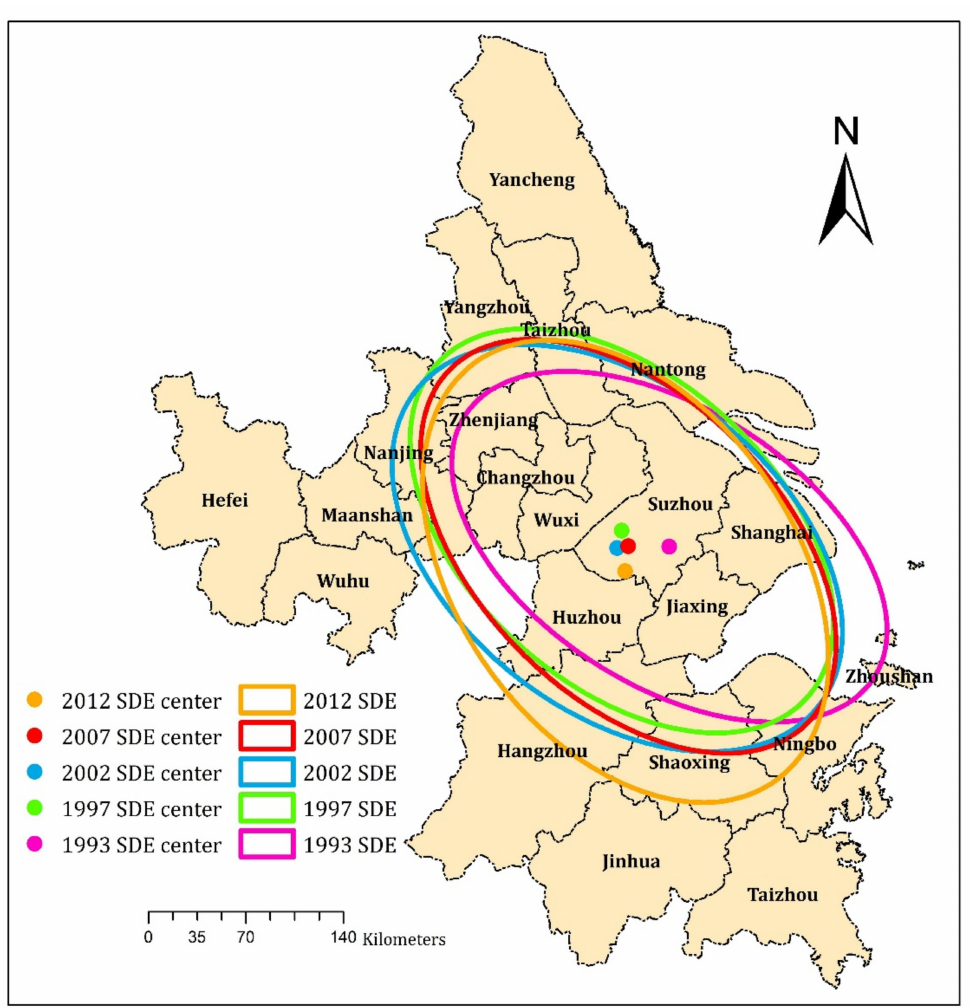
Figure 5. Map of standard deviational ellipses (SDEs) for 1993 to 2012 for the